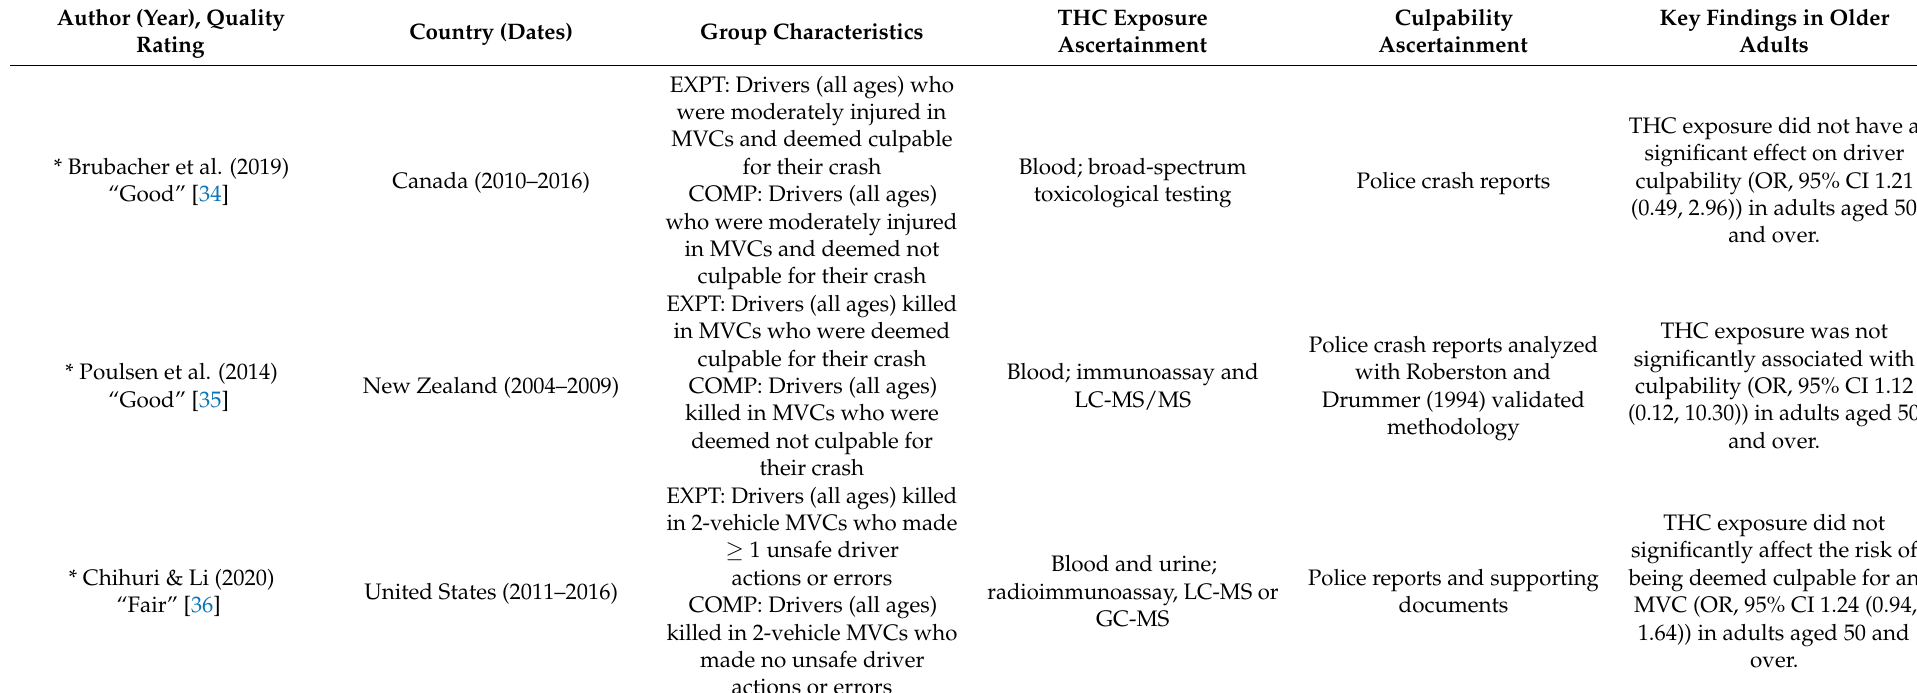
Table 3. Characteristics and Results of the Included Culpability